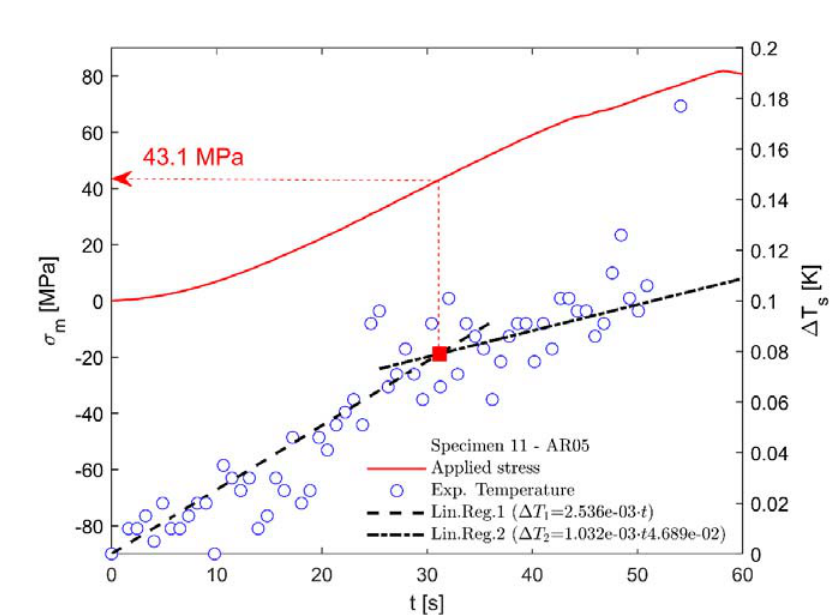
Figure 9:  T vs time curve (blue points) and stress vs time curve (red line) for area AR05 of Specimen